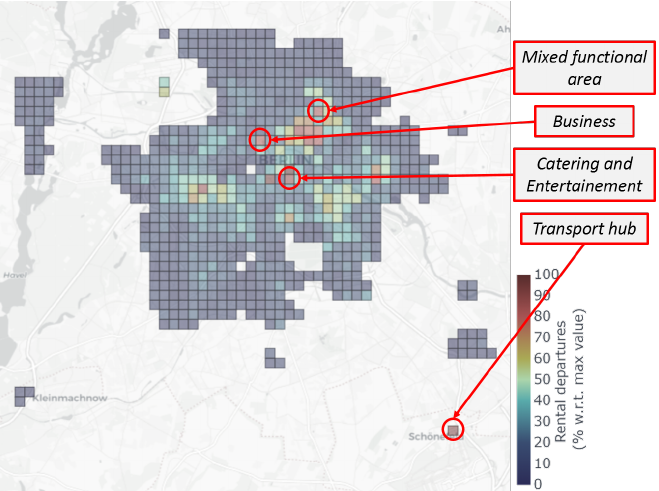
Figure 3. Position of the selected